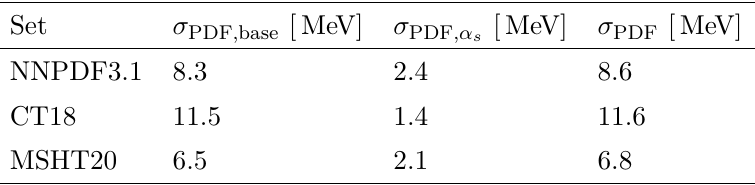
Table 5 . Uncertainties for the NNPDF3.1, CT18 and MSHT20 sets. The contributions from the PDF uncertainty with fixed α and from the α variation are quoted separately as is their sum in s s quadrature, which defines the total uncertainty for each PDF set.